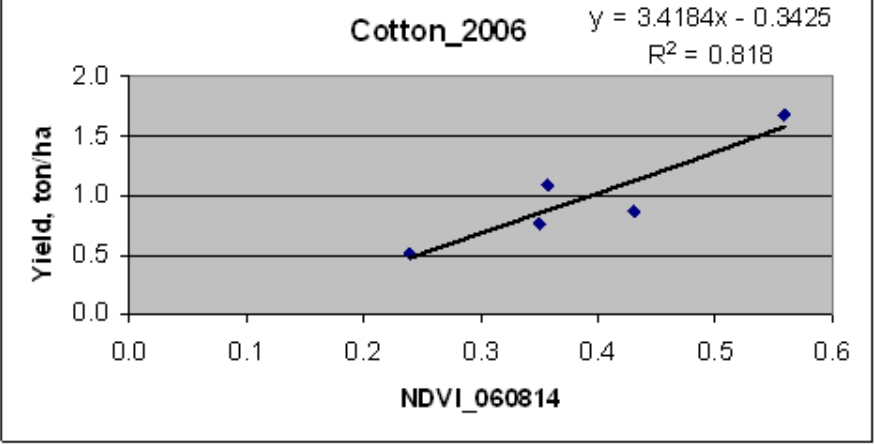
Figure 6. Measured cotton yield versus Landsat ETM+ NDVI relationship from test fields of Galaba study area.